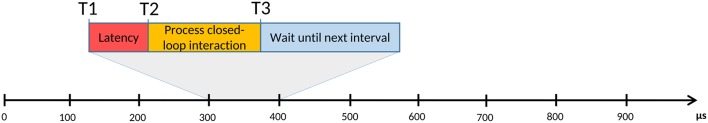
Representation of a typical real-time process, consisting on a succession of fixed and equal duration time intervals that are repeated on each iteration of a periodic loop. For any of these intervals, T1 is the time when it should start, but, due to the system capacity or to its resource management algorithms, the beginning can be delayed until T2. The difference between the real start time (T2) and the expected one (T1) is known as latency. After T2, the process computes its iterative task, which finishes at T3. If T3 happens before the next interval start time, the process waits until that moment. On the other hand, if T3 occurs later than the expected start time of the next interval, as a result of a high latency value, a long computational time or both, it would cause a failure on the real-time system. Real-time tasks can be classified according to their tolerance of such events: soft real-time means that some deadlines can be missed under a certain limit, while hard real-time does not tolerate any failure.